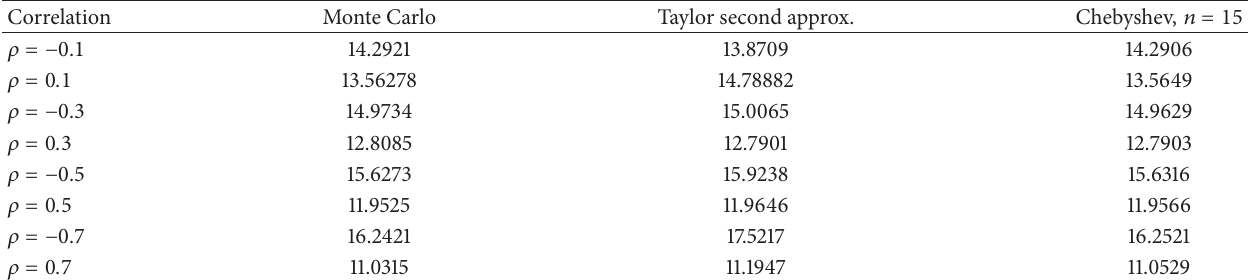
Table1:Spreadpricesforthebenchmarkparametersandseveralvaluesof 𝜌 ,usingMonteCarlo,aTaylorsecond-orderapproximationaround 𝑦 ∗ = 0 , and a Chebyshev approximation with 15 terms, 𝑎 = −4 and 𝑏 = 0.25 .